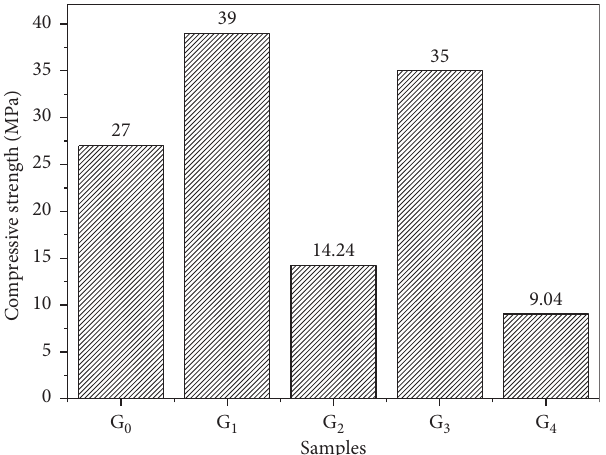
Figure 6: Compressive strength of geopolymer matrix cured at room temperature with different ratio between NaOH and